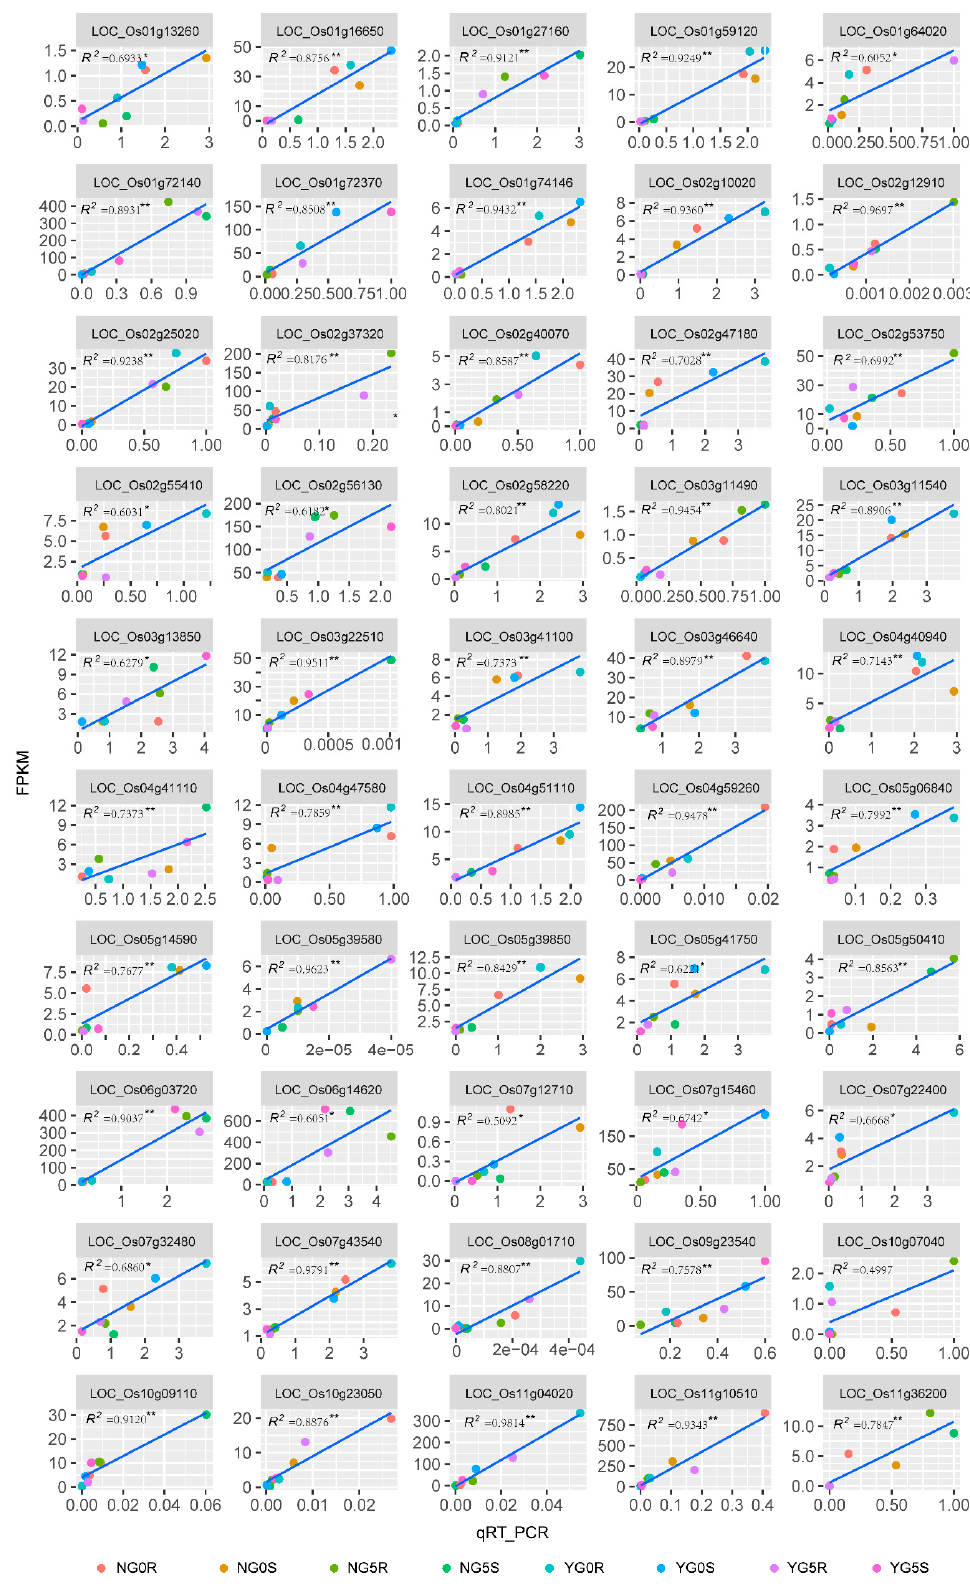
Figure 4. Correlation of RNA-seq results and qRT-PCR validation in 50 representative genes. * ( p ≤ 0.05) and ** ( p ≤ 0.01) represents significant di ff